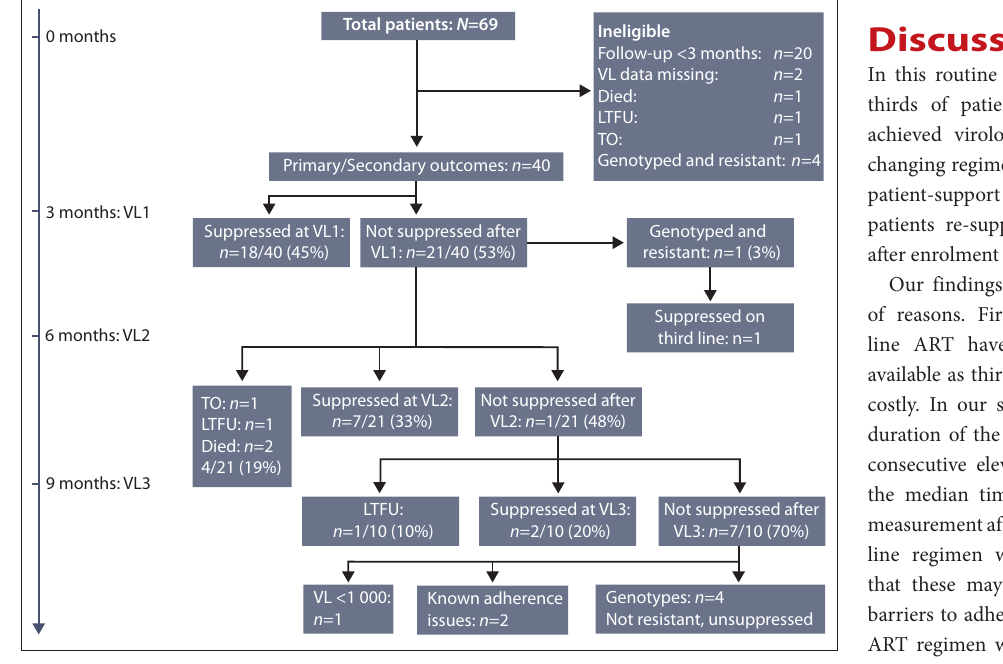
Fig. 2. Flow diagram of outcomes of patients failing second-line antiretroviral therapy enrolled in a comprehensive medical and counselling patient support programme at a primary healthcare clinic, in Khayelitsha, South Africa in 2011. (TO = transfer out; LTFU = loss to follow-up; VL1, VL2, VL3 = first, second and third VL measurements after enrolment into the